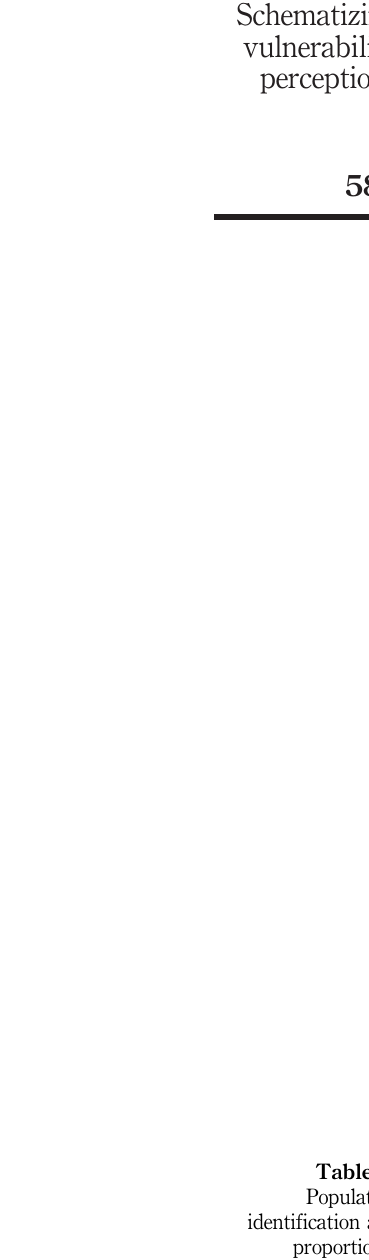
identification and proportional